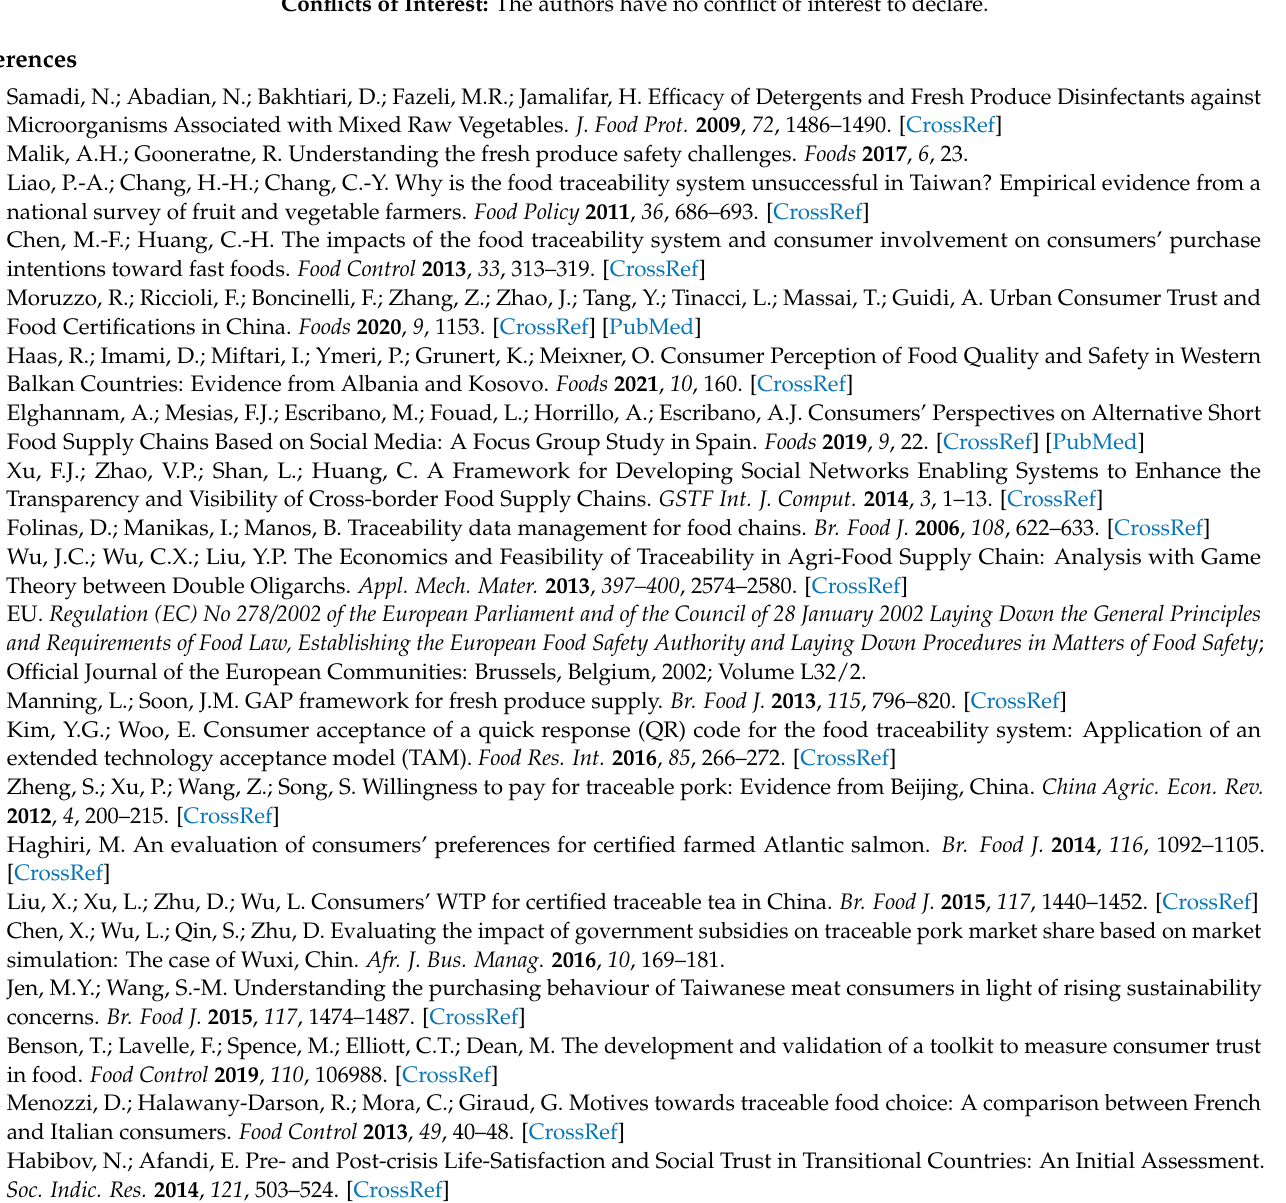
Supplementary Materials: The data are available at Figshare.